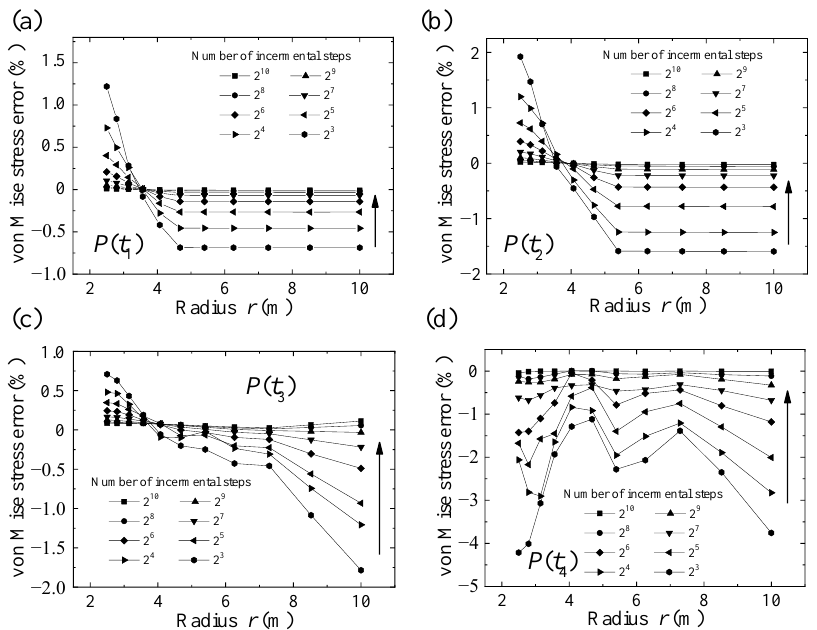
Figure 4. Comparison of LIM and ABAQUS: ( a ) load-displacement diagram and ( b ) von Mises stress along radius.